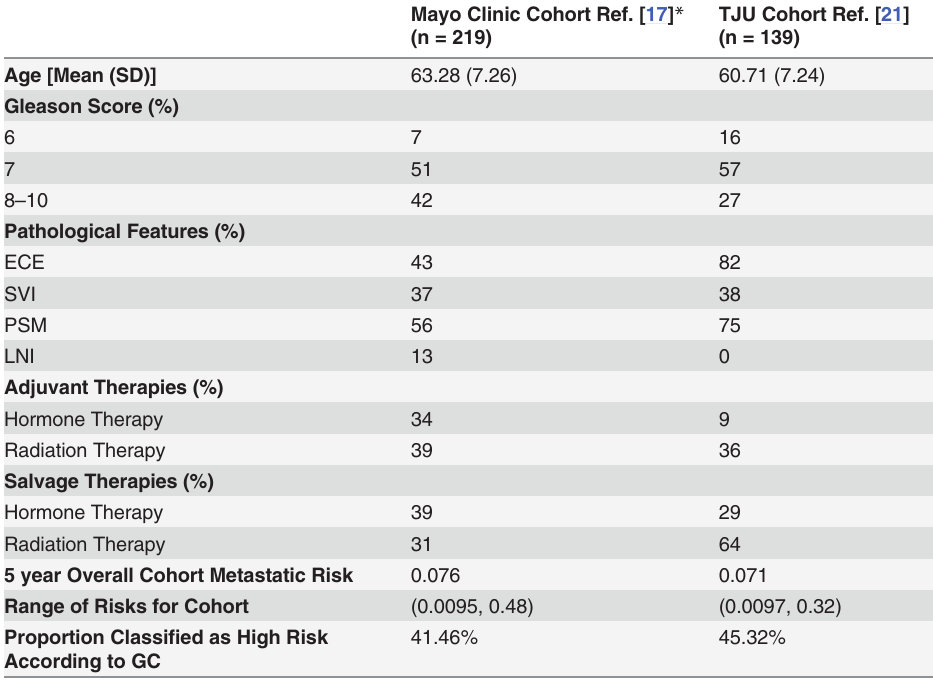
Table 1. Descriptions of patient characteristics for each